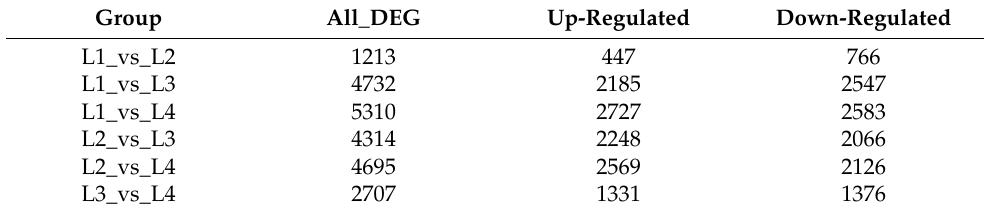
Table 2. Number of DEGs at different instars of M. alternatus